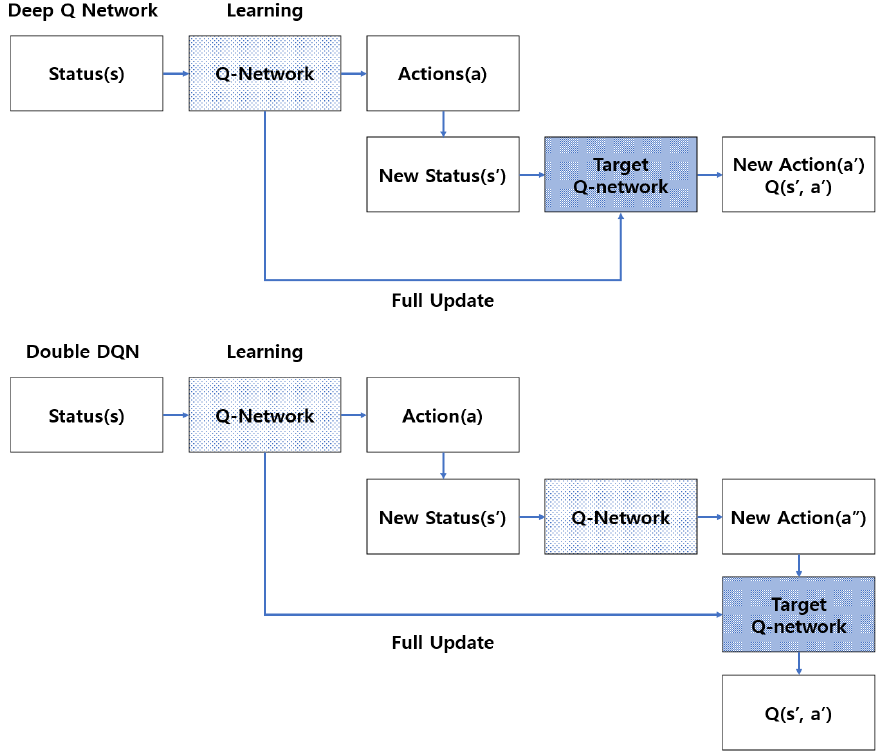
Figure 1. Structure of learning using the target network in DQN & Double DQN.